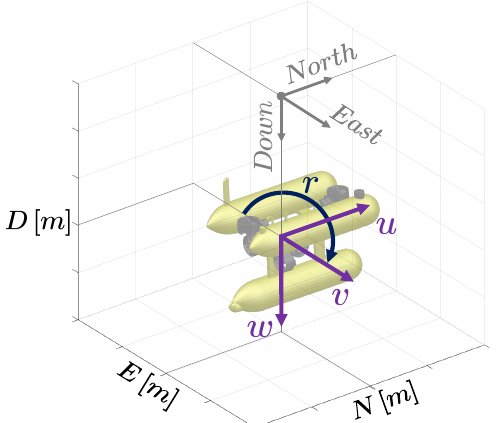
Figure 2. Simplified AUV model utilizing the NED local coordinate system. AUV motion is repre- sented by surge u , sway v , heave w , and angular velocity r around the z-axis.